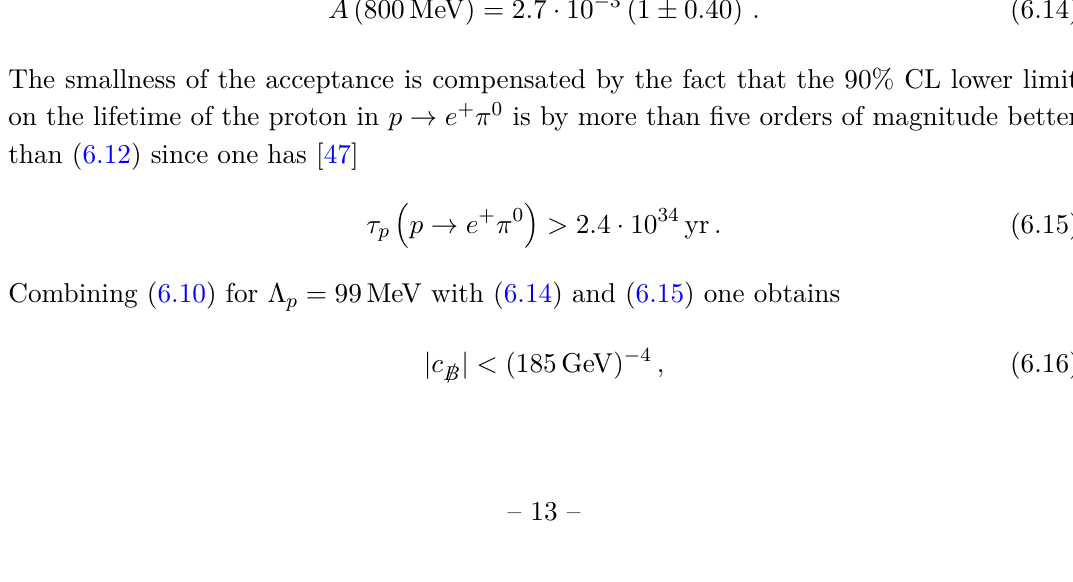
Figure 3 . Acceptance (6.11) as a function of the cut m eπ > m cut the e + π 0 system. The red curve indicates the central prediction, while the red band illustrates the maximal variations that result from considering all possible combinations of the form factor parameterisations (5.1) to (5.4) in the fiducial decay width keeping the inclusive decay width fixed at the central value. See text for further